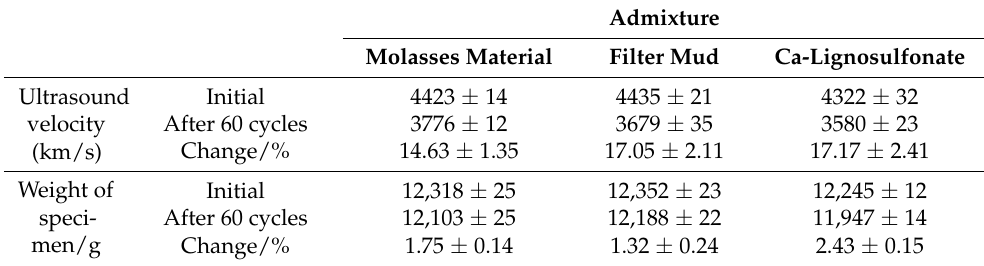
Table 7. The changes of ultrasound velocity and weight of concretes under wetting–drying cycles.